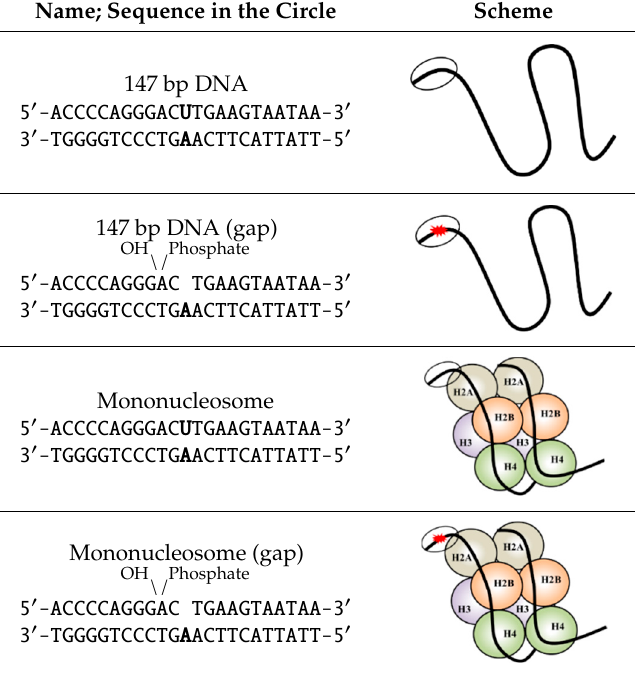
Table 2. Schematic representation of the 147 bp DNA and mononucleosome substrates used in this study. The sequence of the 23 bp region indicated by the circle is presented. The star denotes the position of the one-nucleotide gap formed after uracil-DNA glycosylase (UDG) and EndoIII treatment. Name; Sequence in the Circle